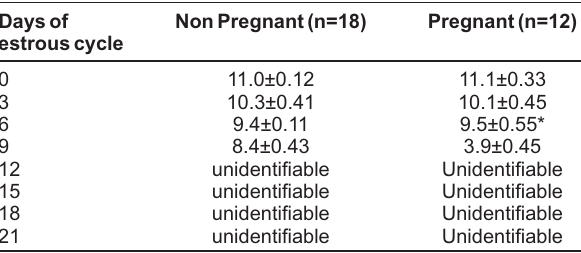
Table-4. Elasticity of cervico-vaginal mucus in pregnant and non pregnant animal. Unit- length of rope (in centimeter) formed on dropping some mucus from catheter to glass